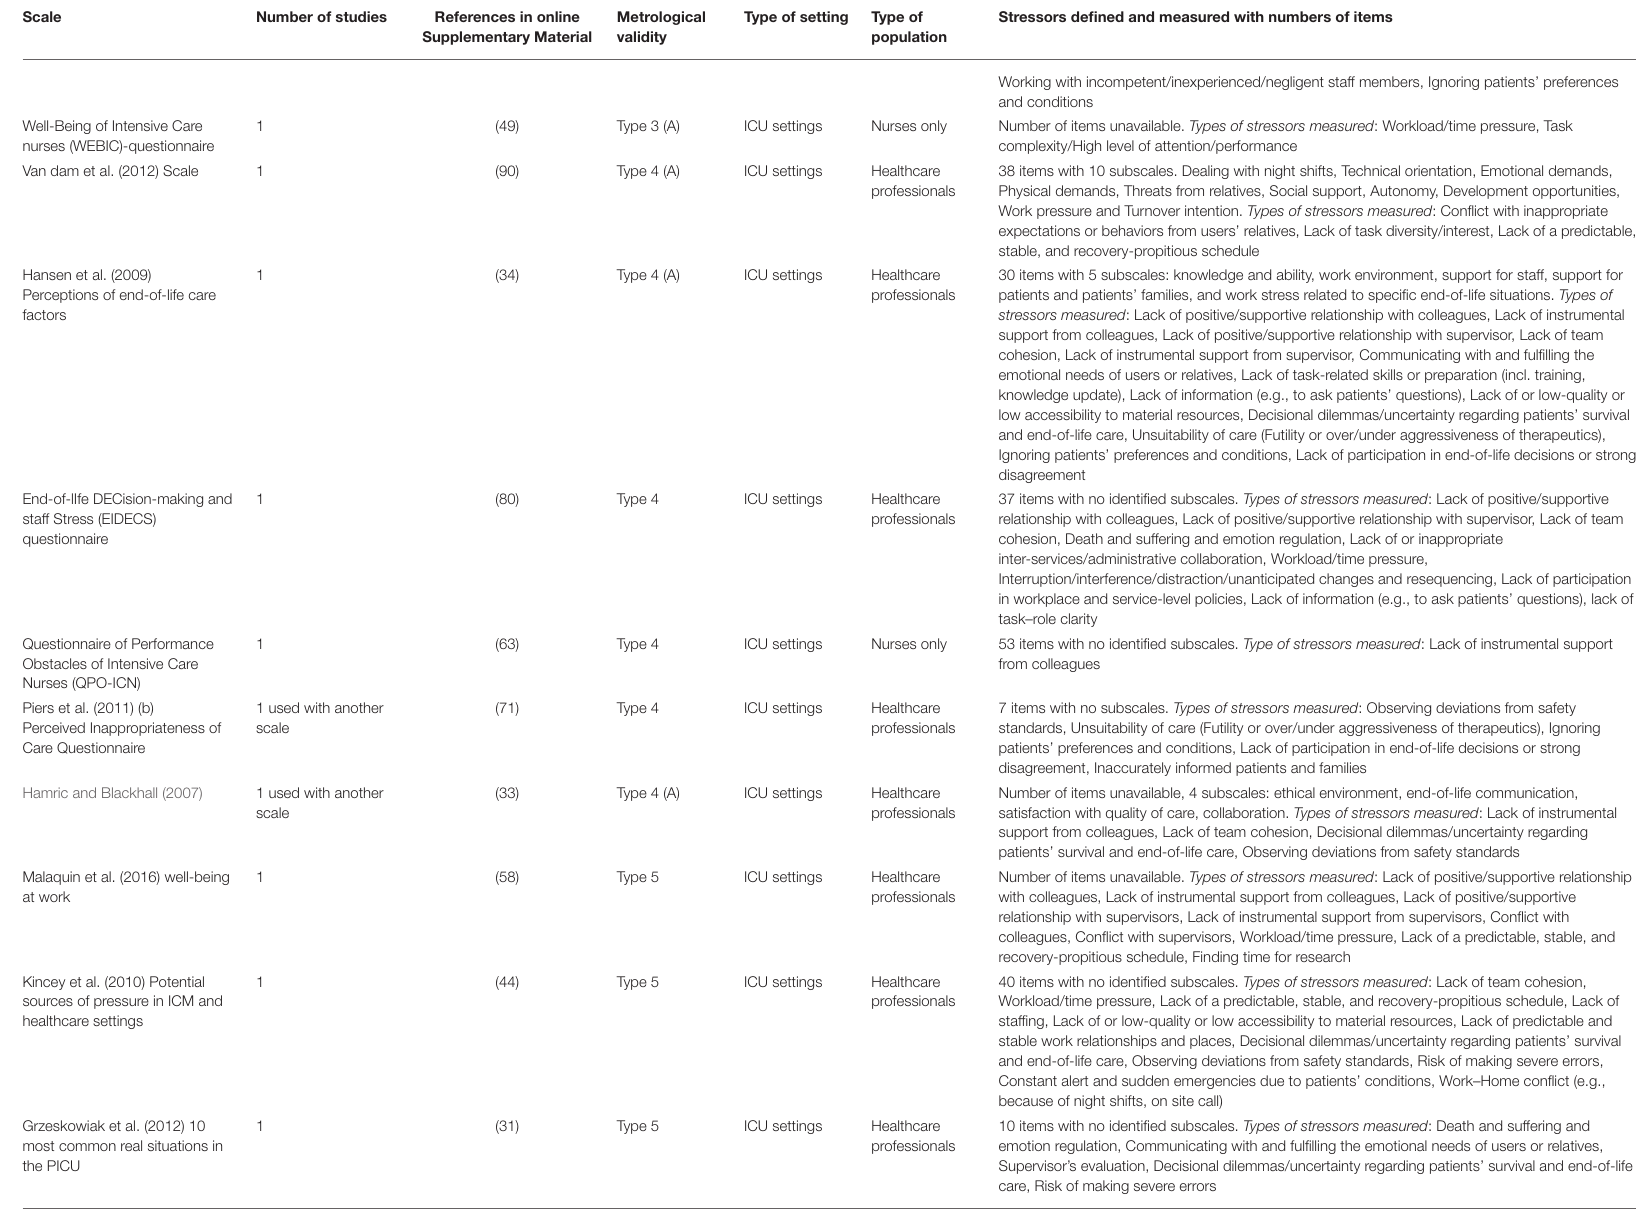
Questionnaire of